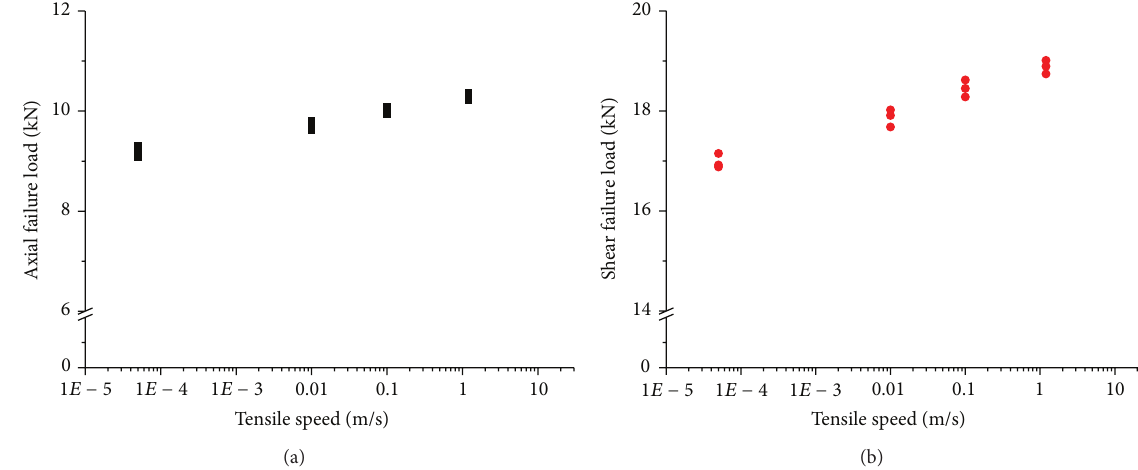
Figure 11: Dynamic sensitivity of failure loads of DP590 spot weld: (a) axial failure load; (b) shear failure load.